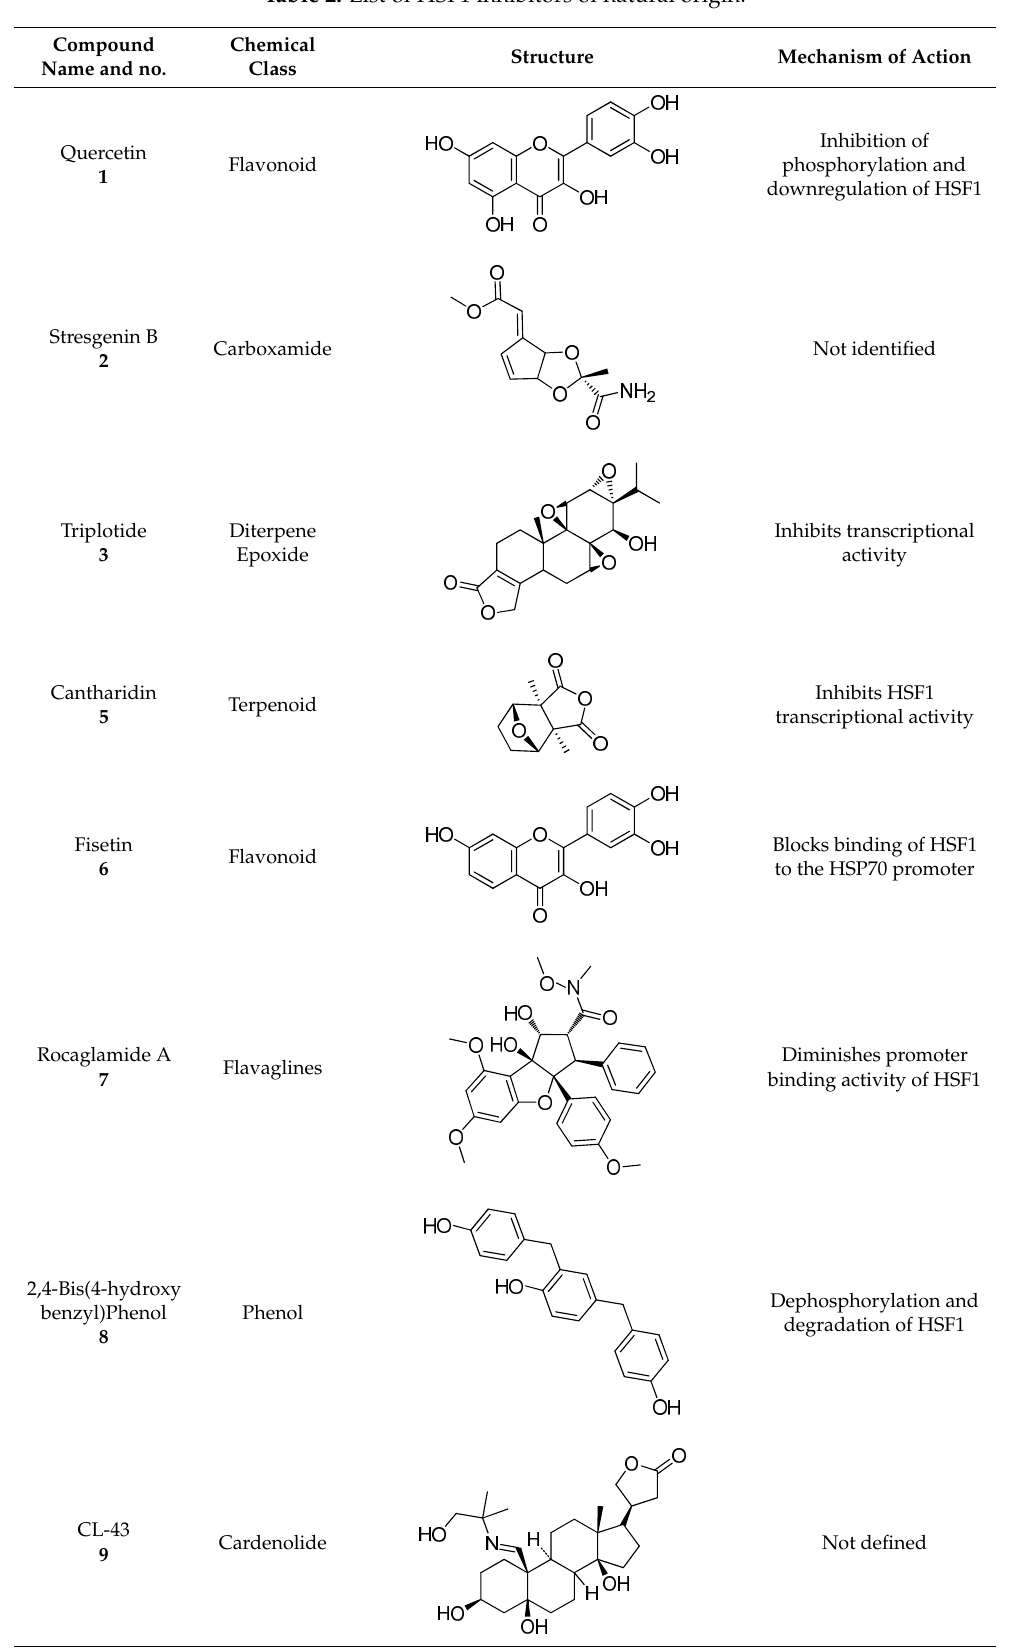
Figure 3. Chemical structure of celasterol. A cell-based screening with a library of diverse marketed and experimental drugs resulted in the identification of cantharidin ( 5 ) as a potent HSF1 inhibitor [35]. It inhibited heat shock-induced luciferase activity with an IC 50 of 4.2 μM. Cantharidin chemically belongs to terpenoids. It can inhibit HSF1 transcriptional activity. In another cell-based screening of 760 structurally diverse natural compounds, Fisetin ( 6 ), a dietary flavonoid, was identified as an inhibitor of HSF1 [36]. It inhibits heat shock-induced luciferase activity in HCT-116 cancer cells with an IC 50 of 14 μM. It further shows the antitumor effect of HSF1 inhibition in vivo in HCT-116 with a GI 50 of 23 μM. The mechanism of inhibition by Fisetin was by inhibiting the binding of HSF1 to promoter region of HSP70. Continued efforts to find better HSF1 inhibitors have prompted Santagata et al. [37] to integrate chemical and genetic approaches to screen more than 600,000 gene expression and more than 300,000 compounds. Rocaglamide A ( 7 ) belonging to a class of natural products called flavaglines was identified as a translation initiation inhibitor. It modulates tumor energy metabolism and selectively targets pre-malignant cells with early-stage oncogenic lesions. The mechanism for its effects on translation inhibition of HSF1 activity is believed to be subtle changes in translation activity involving eIF4A and/or other initiation factors. Yoon et al. [38] also found a new inhibitor 2,4-Bis(4-hydroxybenzyl)phenol ( 8 ) by screening natural products isolated from several herbal medicines. This 2,4-Bis(4-hydroxybenzyl)phenol was isolated from rhizomes of Gastrodia elata . The mechanism of action of this new inhibitor was by inducing dephosphorylation of HSF1 at S326. Subsequently, the HSF1 protein stability is decreased,